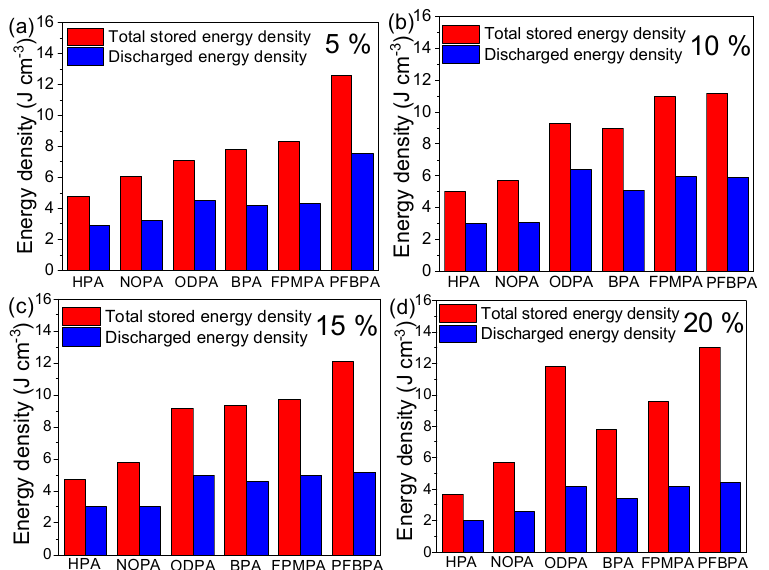
Figure 7. Total energy density and discharged energy density of nanocomposite films with different volume fractions of modified BTs: ( a ) 5 vol%, ( b ) 10 vol%, ( c ) 15 vol% and ( d ) 20 vol%.